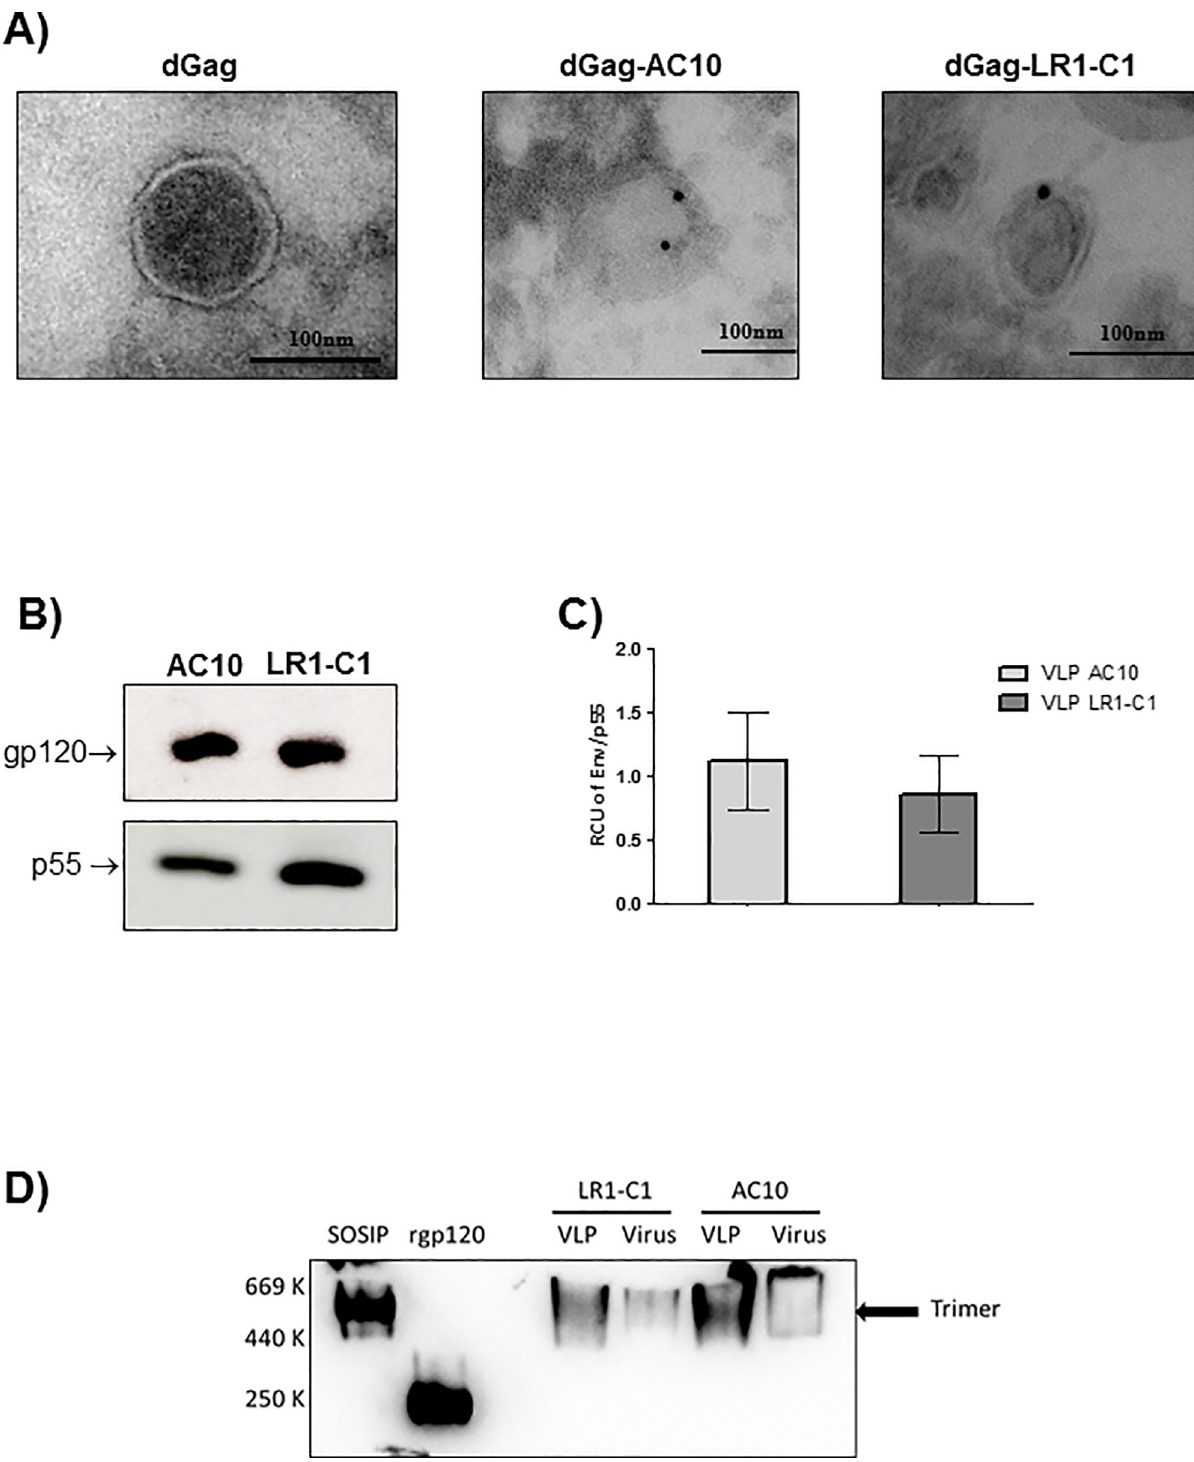
Fig 6. Characterization of the VLPs used for rabbit immunization. VLPs were produced by transfection into 293F cells and VLPs were pelleted from the clarified supernatants. (A) VLPs were analyzed by immunocrioelectromicroscopy labelling with an anti-gp120 antibody, 447-52D. (B) Envelope incorporations in AC10_29 and LR1-C1-VLPs were evaluated by the gp120 and p55 ratios by western blotting in SDS-PAGE gels using 447-52D and p24 (24–4) monoclonal antibodies. (C) Relative Env incorporation into VLPs was calculated by the ratios of gp120 to p55 using phosphorimaging analysis in triplicate. (D) The presence of trimers into AC10_29 and LR1-C1-VLPs and AC10_29 and LR1-C1-virions were analyzed by western